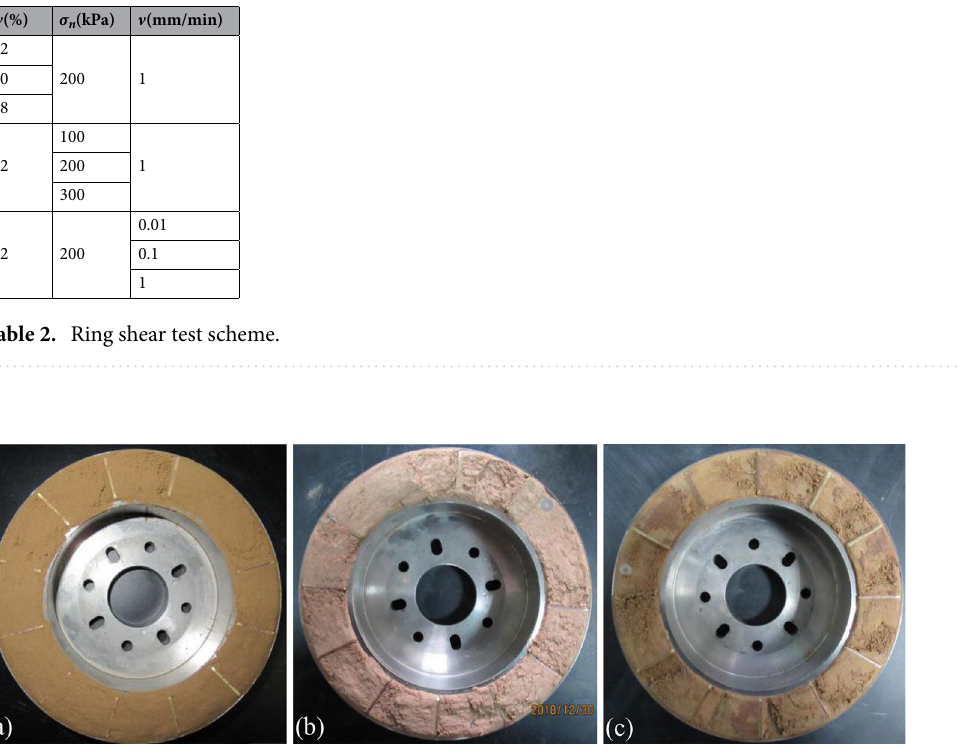
Figure 4. Shear planes of specimen after ring shear tests. ( a ) Loess; ( b ) red clay; (c)